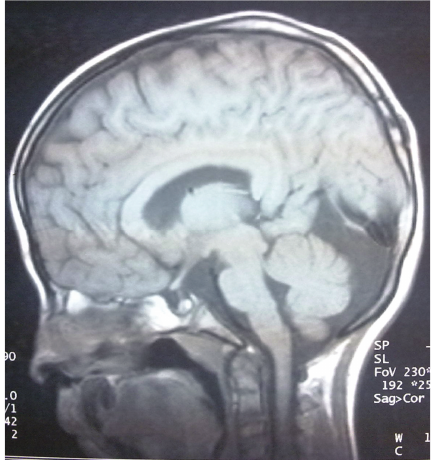
Figure 4: The presence of mega cisterna magna in the retrocerebel- lar